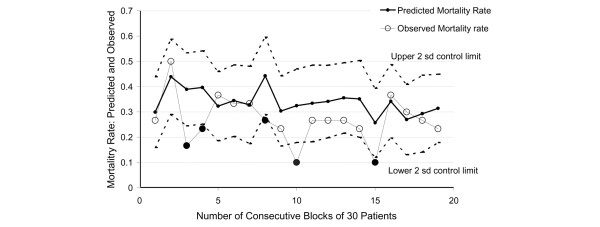
Risk-adjusted p chart by blocks of 30 patients. Probability of death estimated with UK APACHE, Royal Berkshire Hospital, 1 January 2003 to 30 June 2004.